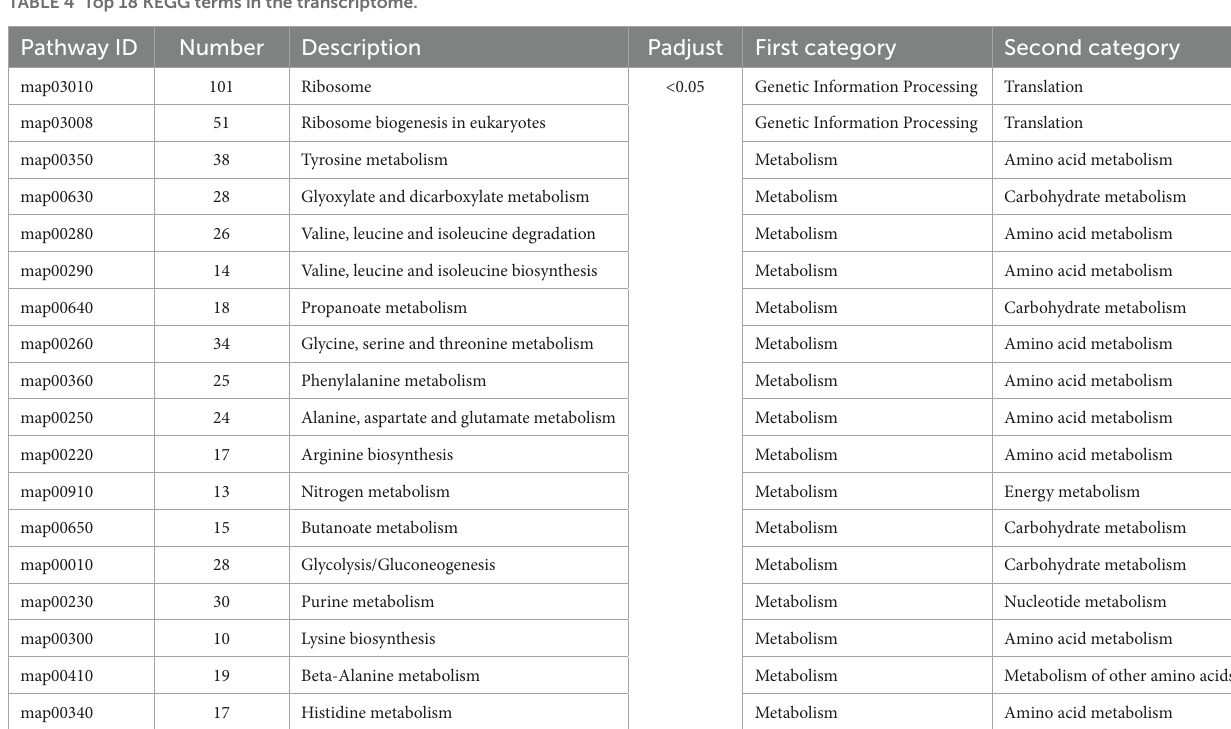
TABLE 4 Top 18 KEGG terms in the transcriptome.